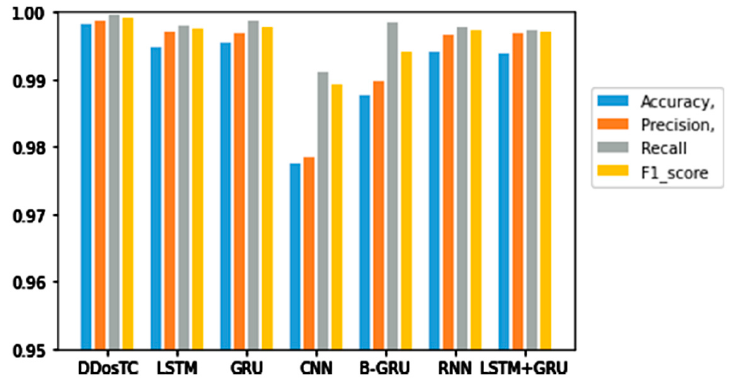
Figure 8. A performance comparison of DDosTC and transformer, transformer + CNN + LSTM, and transformer + LSTM (Train/Test = 6:4).